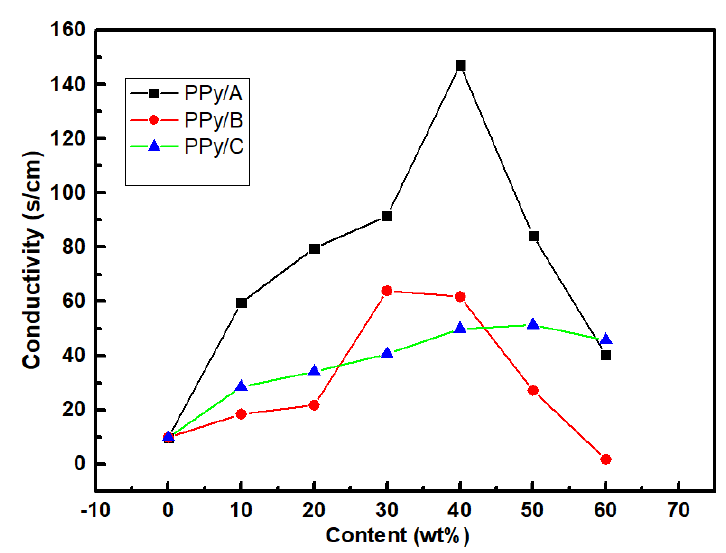
Figure 9. Conductivity of PPy/A, PPy/B and PPy/C.